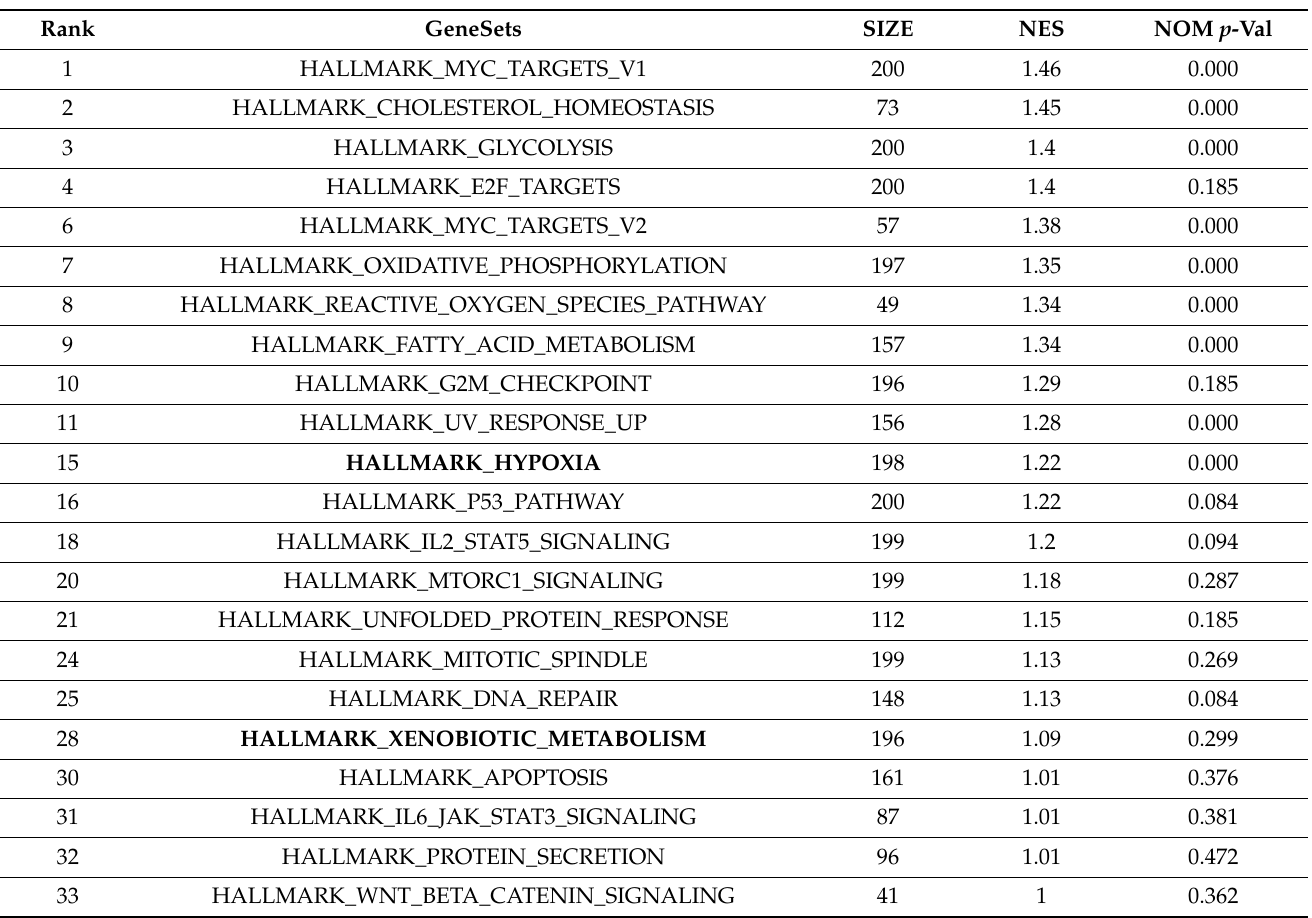
Table 1. Relevant Gene Sets enriched in leukemic B cells compared to normal B cells as revealed by RNA sequencing analysis and GSEA. NES, normalized enrichment score. NOM p -val, nominal p